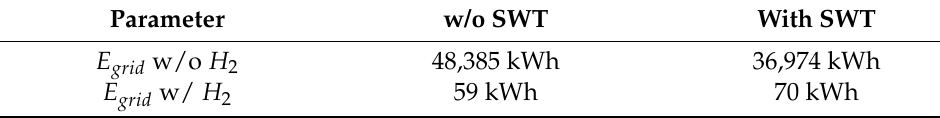
Table 16. Annual electrical energy from grid for different system variants.